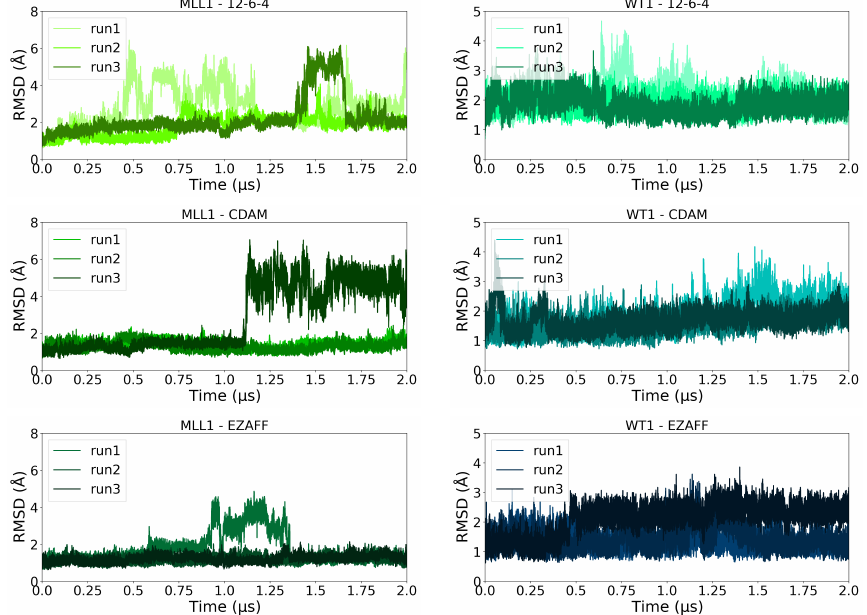
Figure 2. RMSD of protein backbone with respect to the crystal structure for the three different zinc models. Note that the scale of the vertical axis is different for MLL1 and WT1. For RMSD plots of all individual Zn 2 + -ions and their ligating residues, see Figure S9.